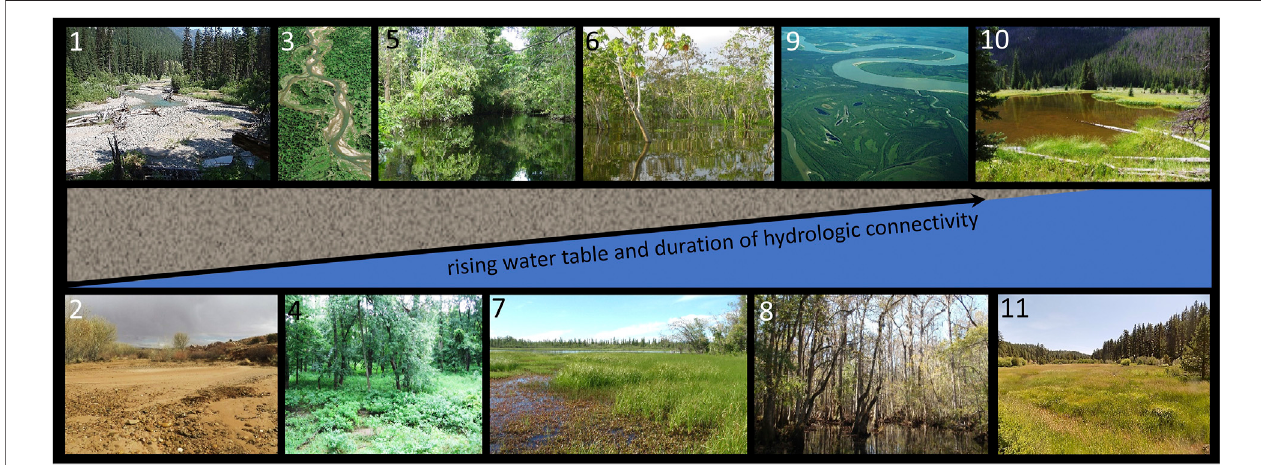
FIGURE 2 | A schematic illustration of the continuum of channel planform, vegetation communities, and fl oodplain water table within wide, low-gradient valley segments.Insetillustrationsare(1)ParkCreek,MT,UnitedStates,(2)HarrisWash,UT,UnitedStates,(3)SwanRiver,MT,UnitedStates(4)bottomlandhardwoodforest along the Illinois River, IL, United States, (5) igapo forest, Amazon River, Brazil, (6) várzea forest on the Amazon River fl oodplain, Brazil, (7) wet meadow and lake, Yukon River, Alaska, United States (8) swamp on the fl oodplain of the Congaree River, SC, United States, (9) muskeg along the fl oodplain of the Yukon River, AK, United States, (10) an abandoned beaver pond in a wet-meadow stream corridor, CO, United States, and (11) wet-meadow stream corridor at Deep Creek, OR, United States.